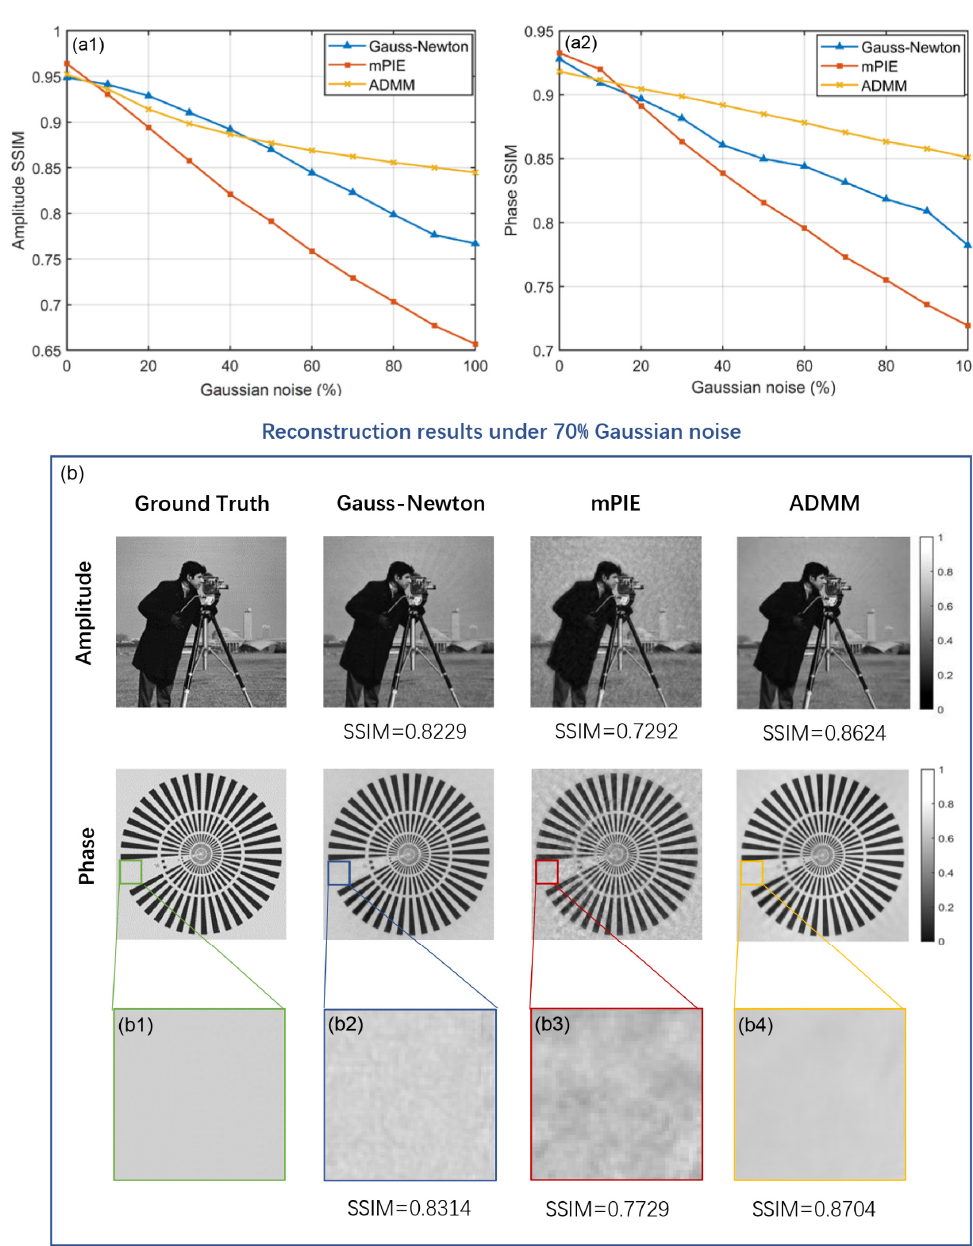
Figure 3. Comparison of simulated reconstruction results under Gaussian noise. ( a1 , a2 ) Amplitude and phase SSIM curves as a function of Gaussian noise level. ( b ) Visual reconstruction results of three algorithms under 70% Gaussian noise with SSIM values marked below the images. Magnified images for the religion of interest in phase reconstruction results are shown in ( b1 – b4 ).